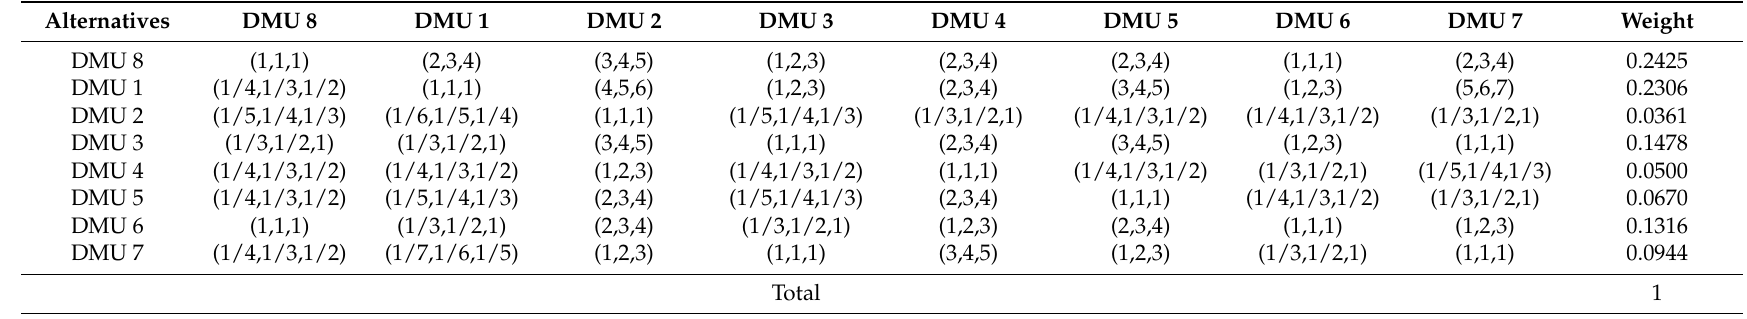
Table A32. Comparison matrix for REP based on alternatives.